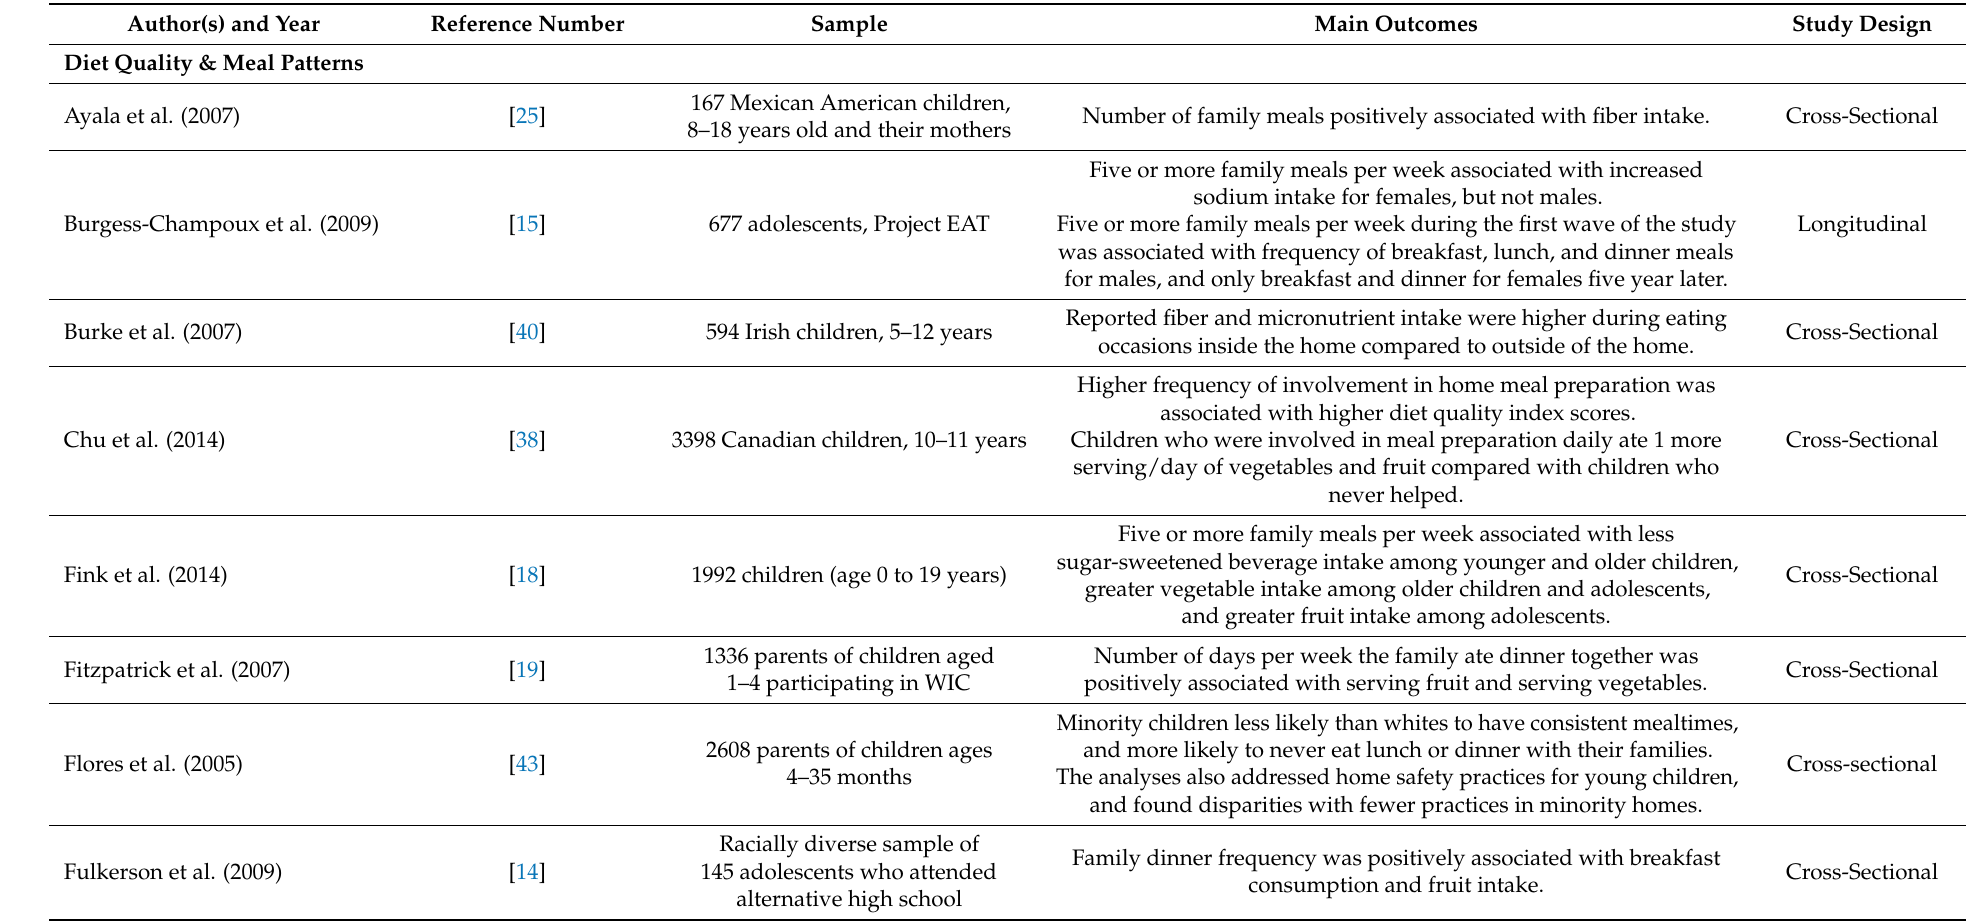
Table 1. Summary of Diet Quality and Meal